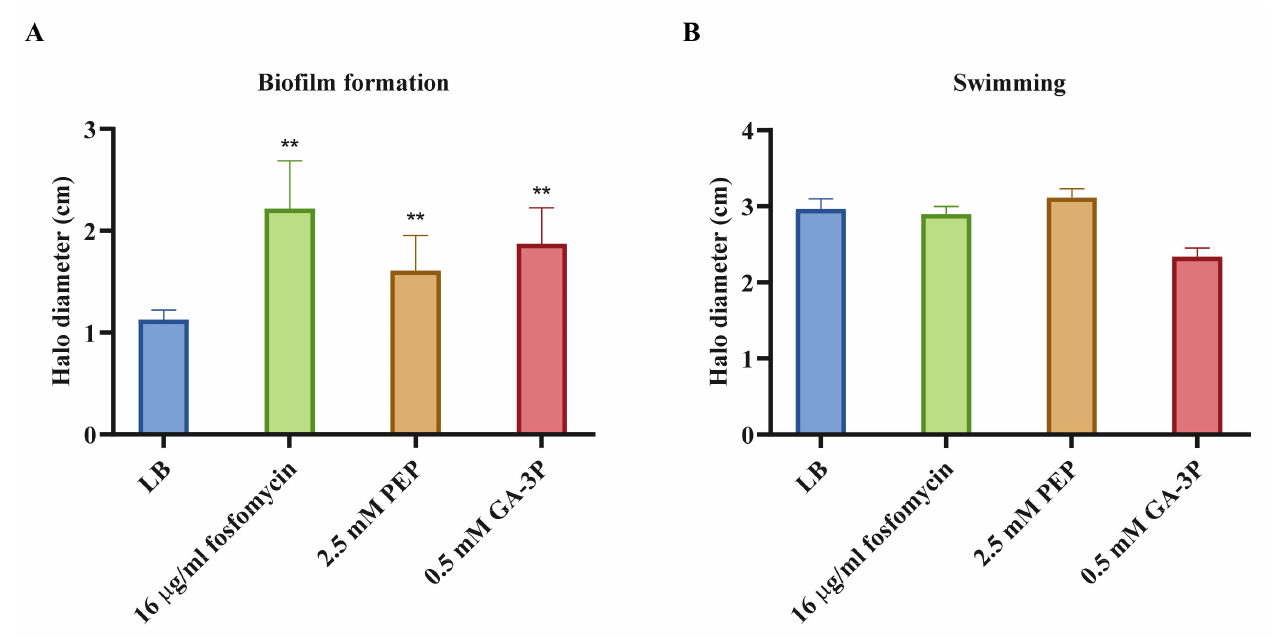
Figure 3. Quantification of chemotaxis- and motility-related phenotypes relevant to the virulence of S. maltophilia after fosfomycin, PEP, and GA-3P treatments. The graphs show the ( A ) biofilm formation and ( B ) swimming motility of S. maltophilia . Error bars indicate standard deviations of the results from eight independent experiments in the biofilm formation assay, and from three experiments in the swimming motility tests. Values that are significantly different based on an unpaired two-tailed t -test are indicated by asterisks, as follows: **: p < 0.009.